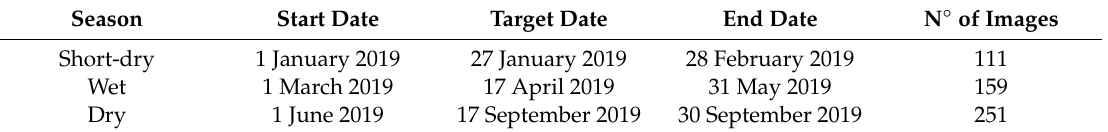
Table 1. Seasonal temporal windows and number of Sentinel images used in each